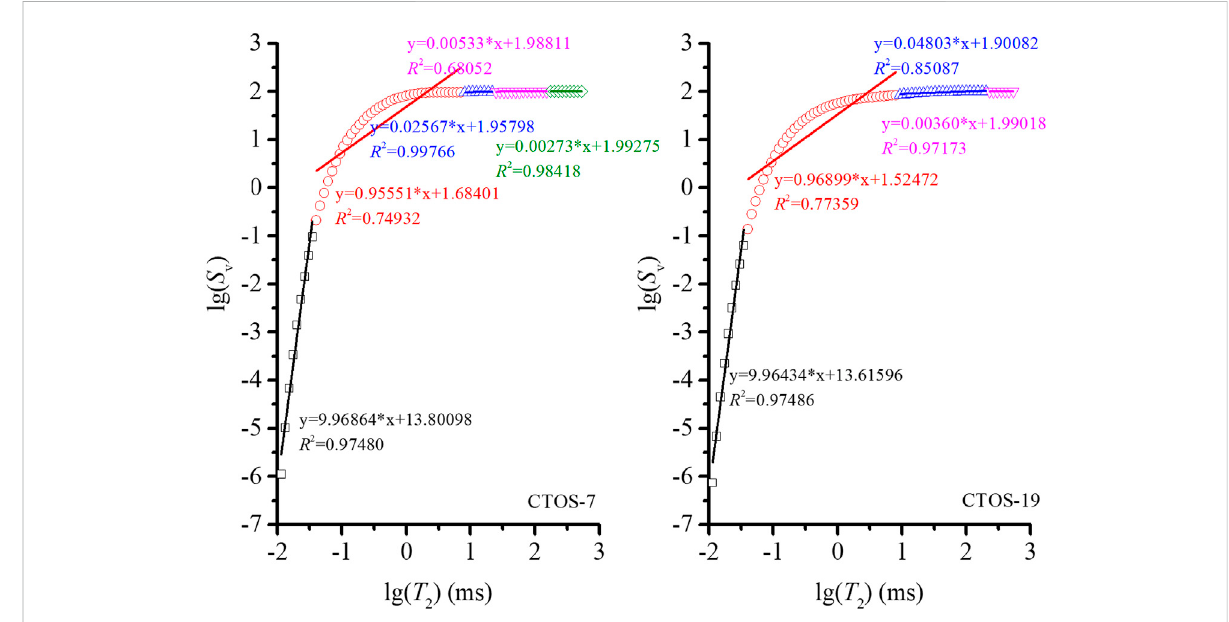
FIGURE 8 The pore fractal dimension of various pores in CTOS-7 and CTOS-19 samples.